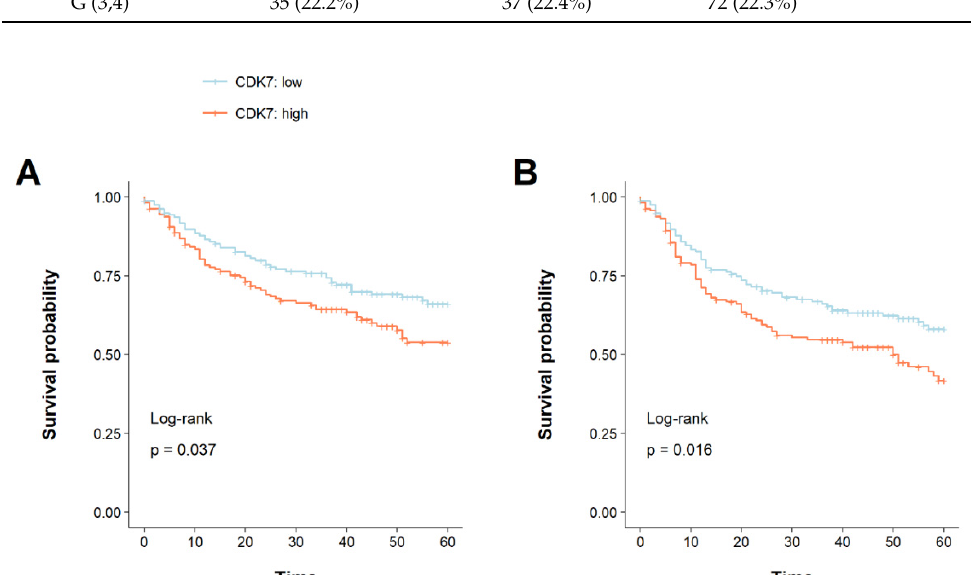
Figure 2. Kaplan–Meier graphs with a p -value of log-rank test of ( A ) 5-year overall survival and ( B ) 5-year disease-free survival. The cohort was stratified into two groups based on the median expression of CDK7. Expression above the median was considered as high expression conversely expression below the median was considered as low expression. Upregulation of CDK7 correlated with a significantly shorter OS as well as DFS ( p = 0.037, p = 0.016). Table 2. Cox regression analysis of CDK7 expression. * p < 0.05.